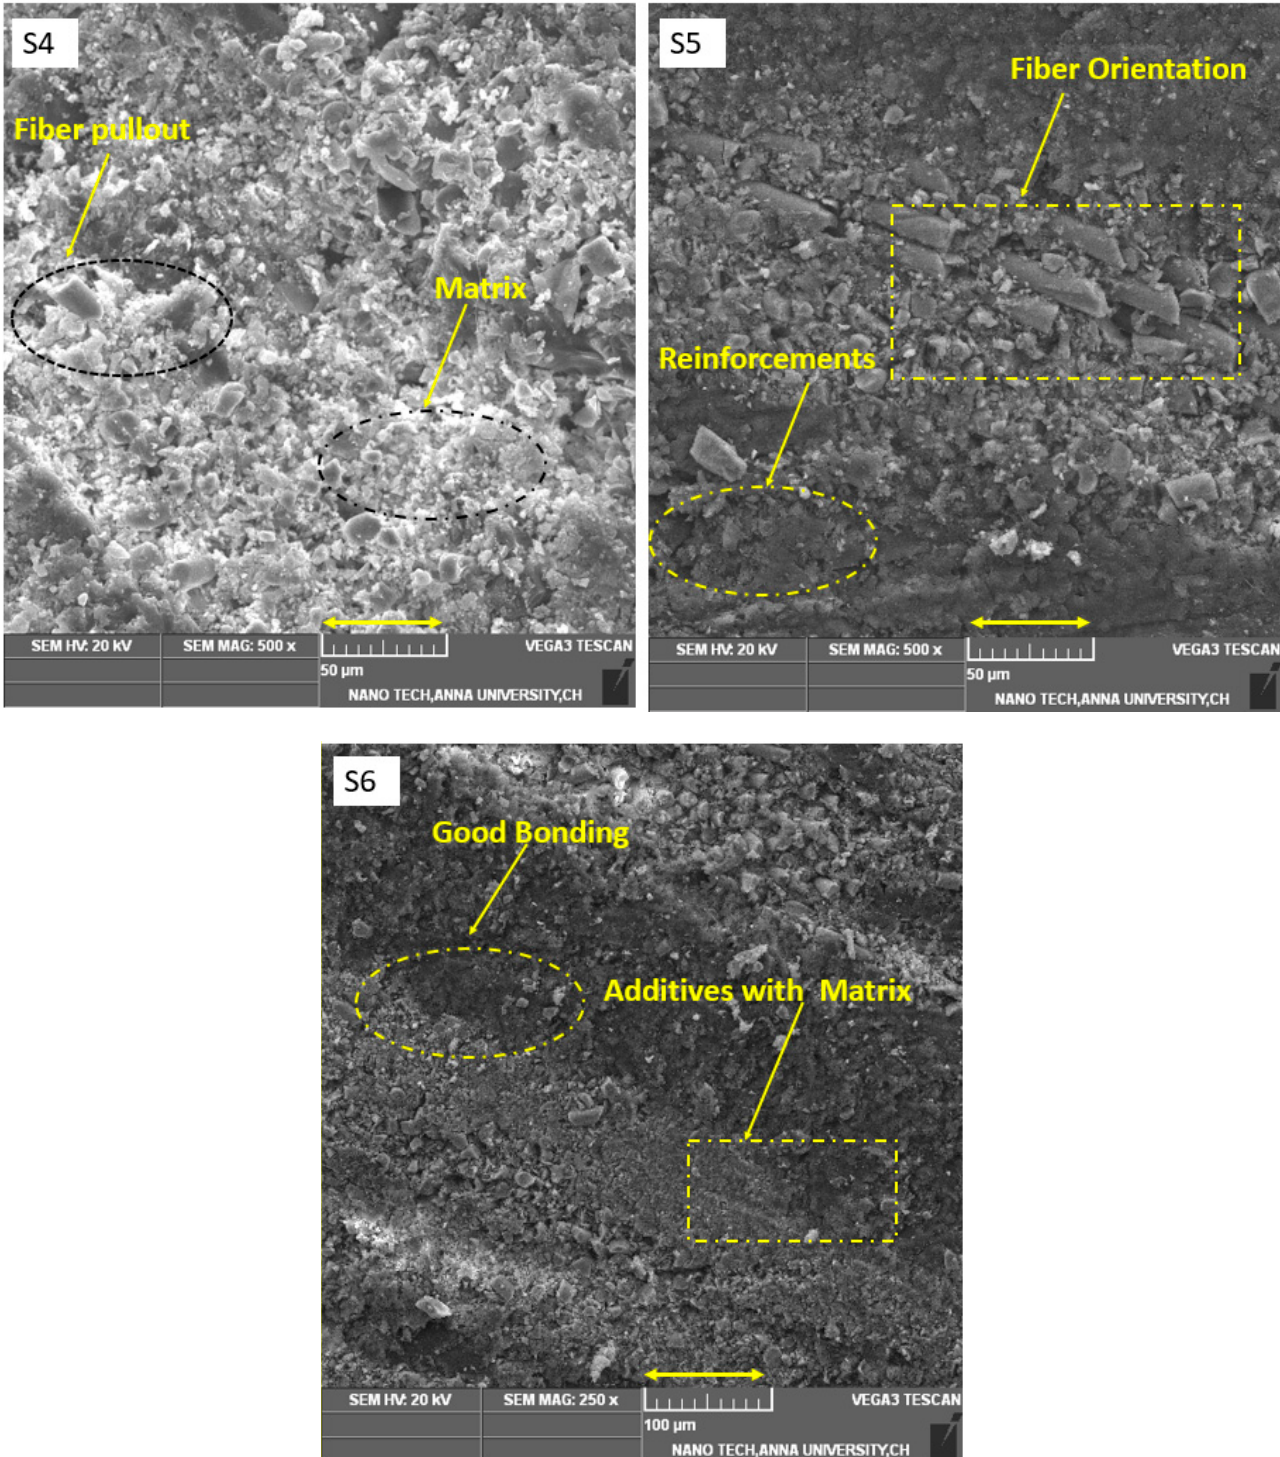
Figure 5. S EM image of the S4, S5, and S6 hybrid composites before testing